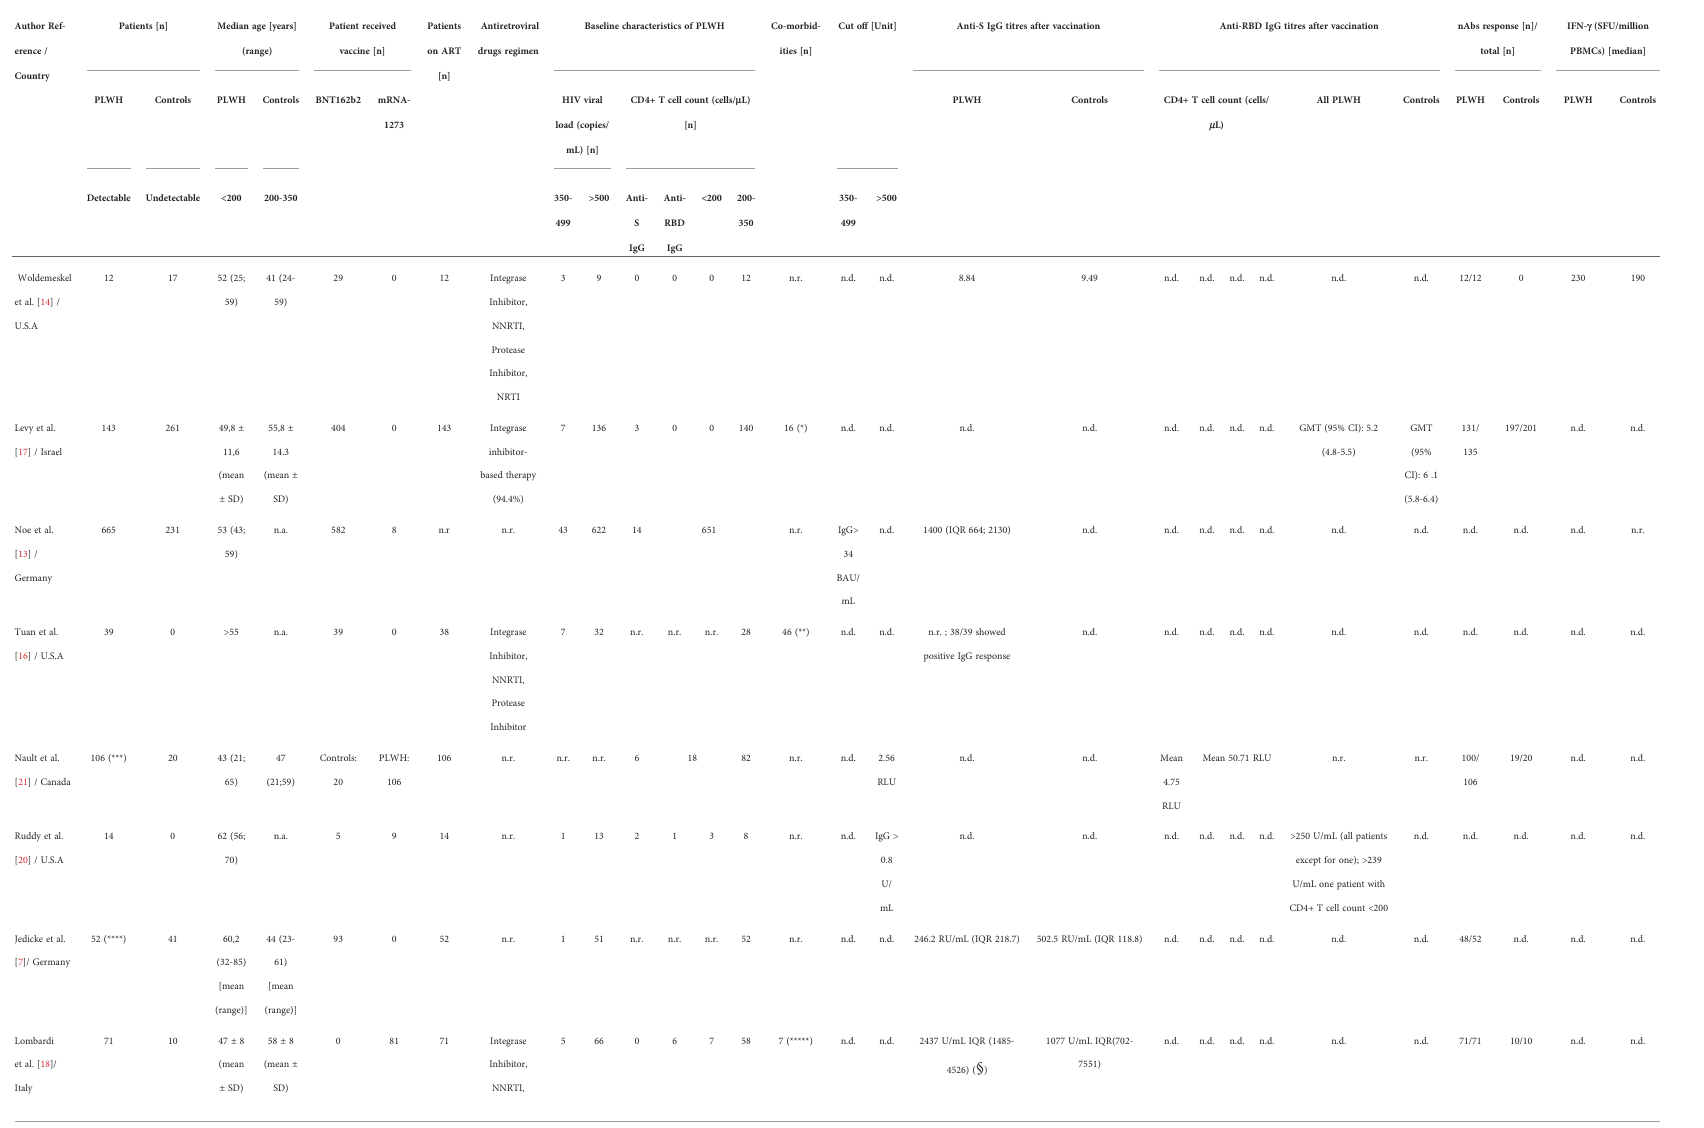
TABLE 1 Summary of HIV-related baseline characteristics and SARS-COV-2 immune responses after COVID-19 mRNA-based vaccination trials in PLWH on diverse ARTs. AuthorRef-